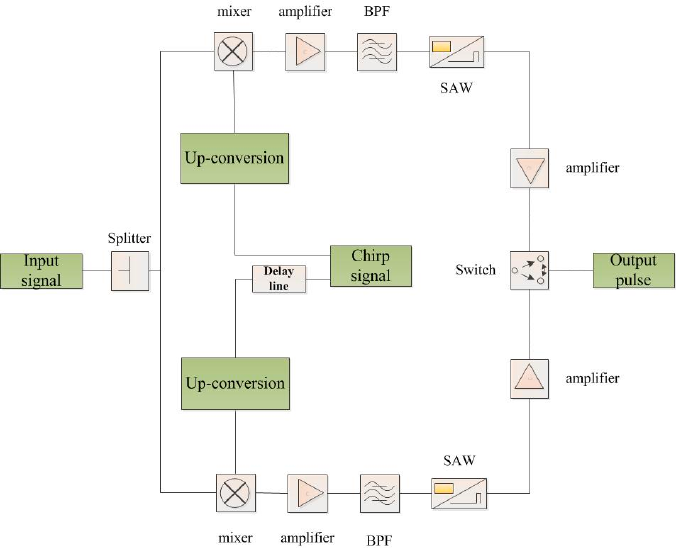
Figure 1. Schematic of classical two-channel M(l)-C(s) transform arrangements for the expander- compressor. BPF represents band-pass filter, SAW represents surface acoustic.